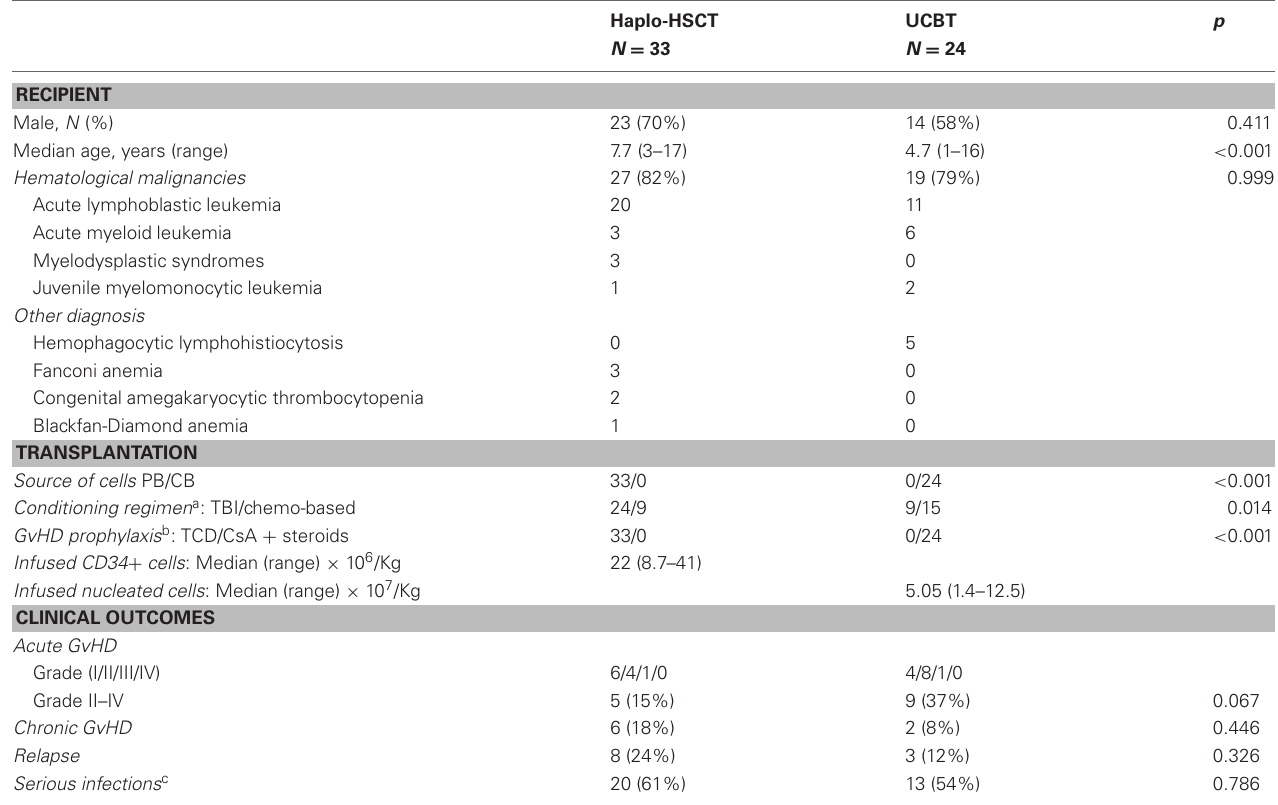
Table 1 | Patient-, donor-characteristics, and transplant